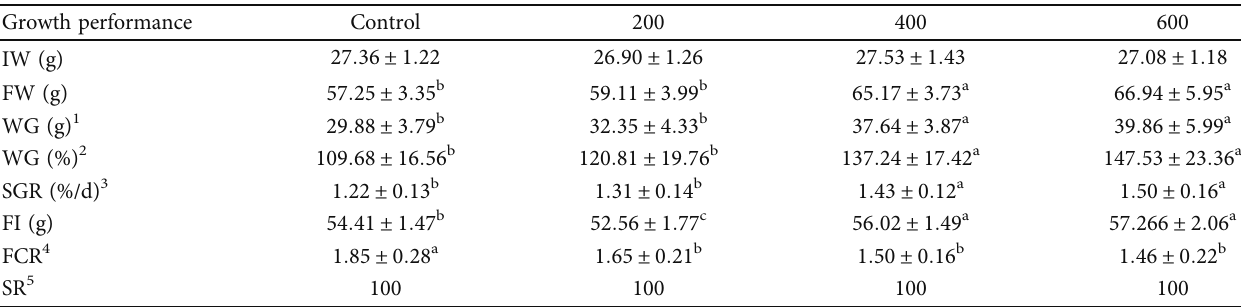
Table 3: Growth performance and feed e ffi ciency of common carp fed with experimental diets after 60 days. Growth performance